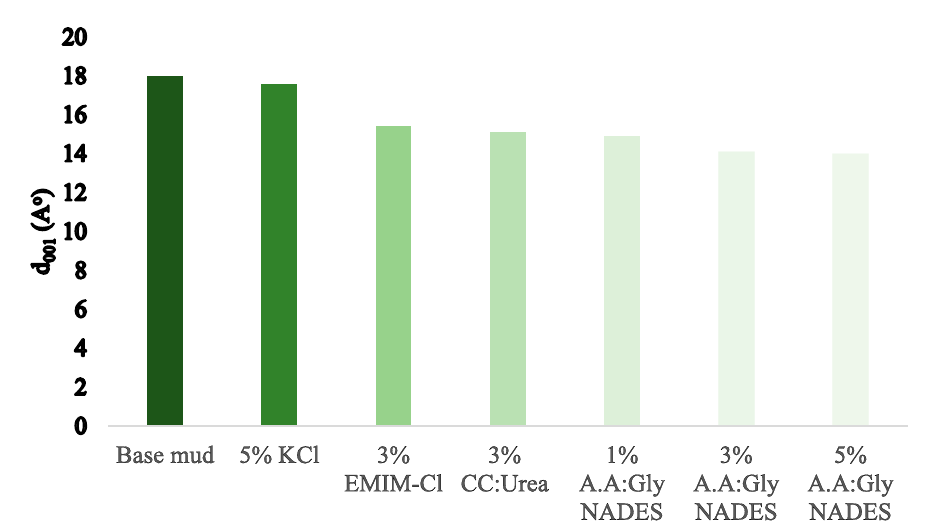
Figure 9. d-spacing of inhibitors-based drilling mud samples.